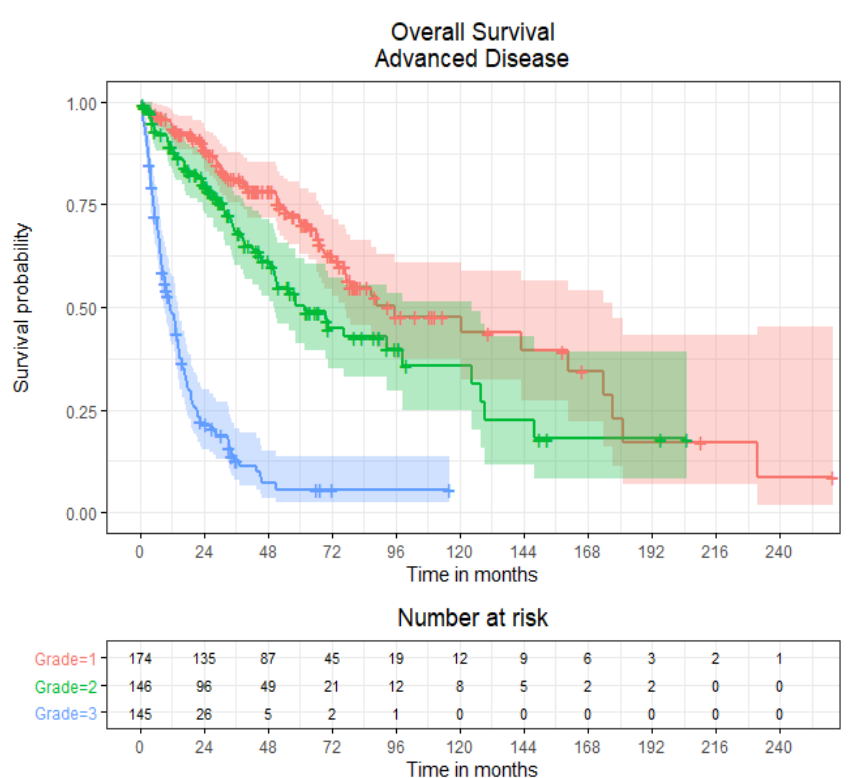
Figure 3. Kaplan – Meier overall survival curves of patients with extra-pulmonary neuroendocrine neoplasms and brain metastases by histological grades 1 + 2 (grouped) and 3.